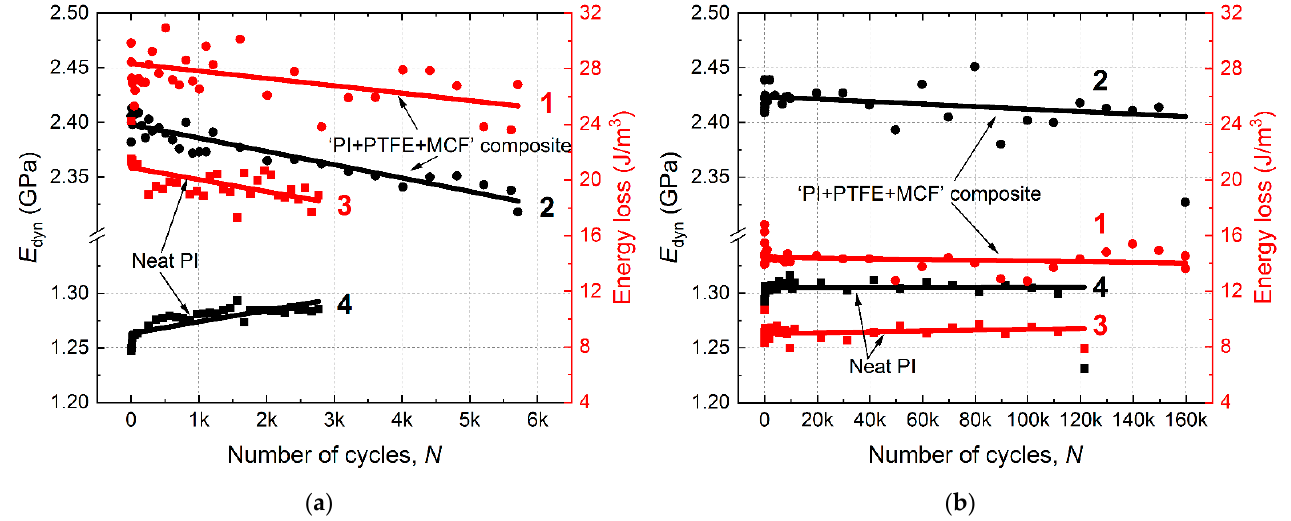
Figure 10. Changes in the dynamic modulus (black) and energy losses (red) vs. the number of cycles for neat PI and the “PI/PTFE/MCF” composite; LCF mode with σ = 1.3 of the yield point ( a ) and HCF mode with σ = 0.7 of the yield point ( b ). Curves designations are the following (1)—Energy loss for “PI/PTFE/MCF”; (2)— E dyn for “PI/PTFE/MCF”; (3)—Energy loss for neat PI; (4)— E dyn for neat PI.